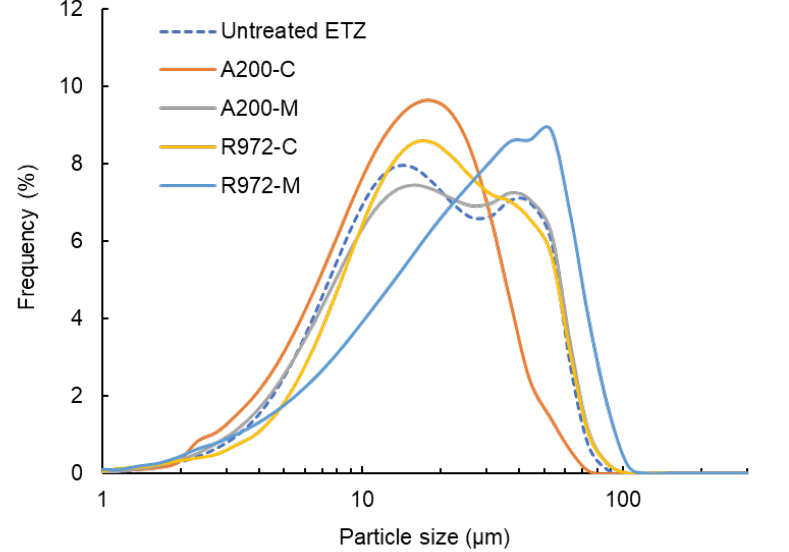
Figure 4. Particle size distributions of ETZ coated with silica nanoparticles using the Mechanomill and Comil methods.